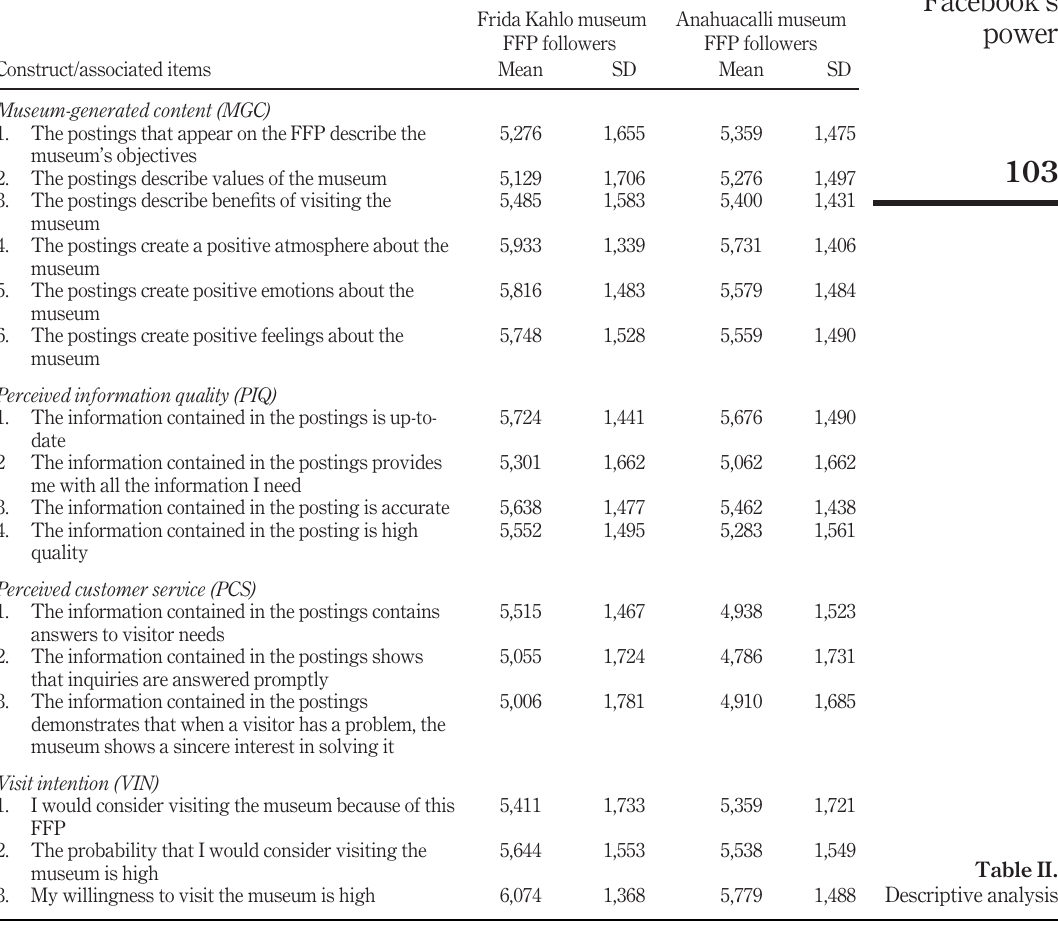
Table III shows the results of the measurement model reliability and convergent validity tests for both samples. Hair et al. ’ s (2011) benchmarks were followed (Table III): standardized indicator loadings were higher than 0.70, a composite reliability higher than 0.70 assured internal consistency, convergent validity was corroborated by an average variance extracted